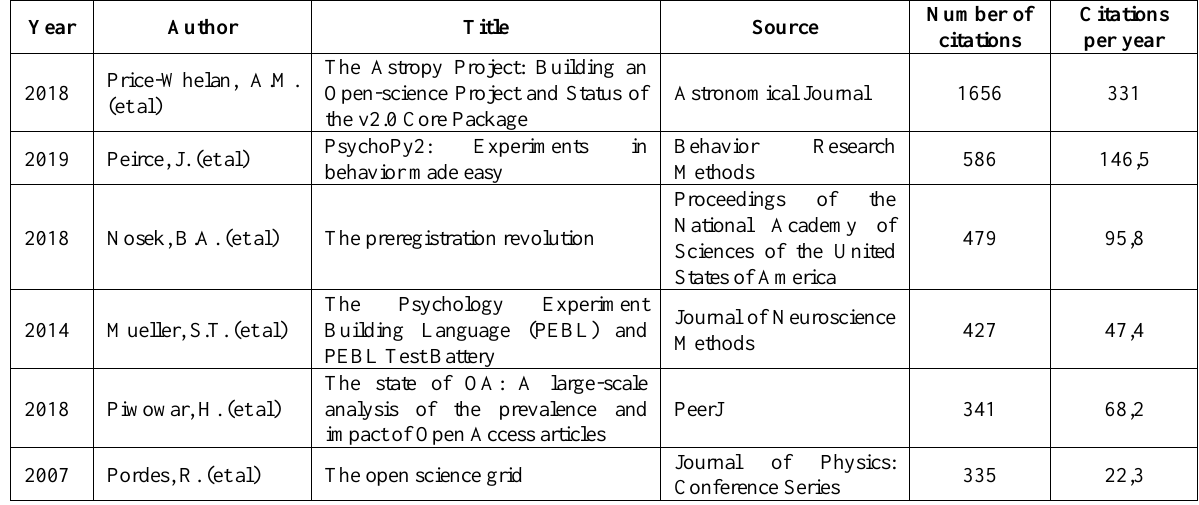
Table 2. The Most Cited Works by the Search Query “Open Science” in